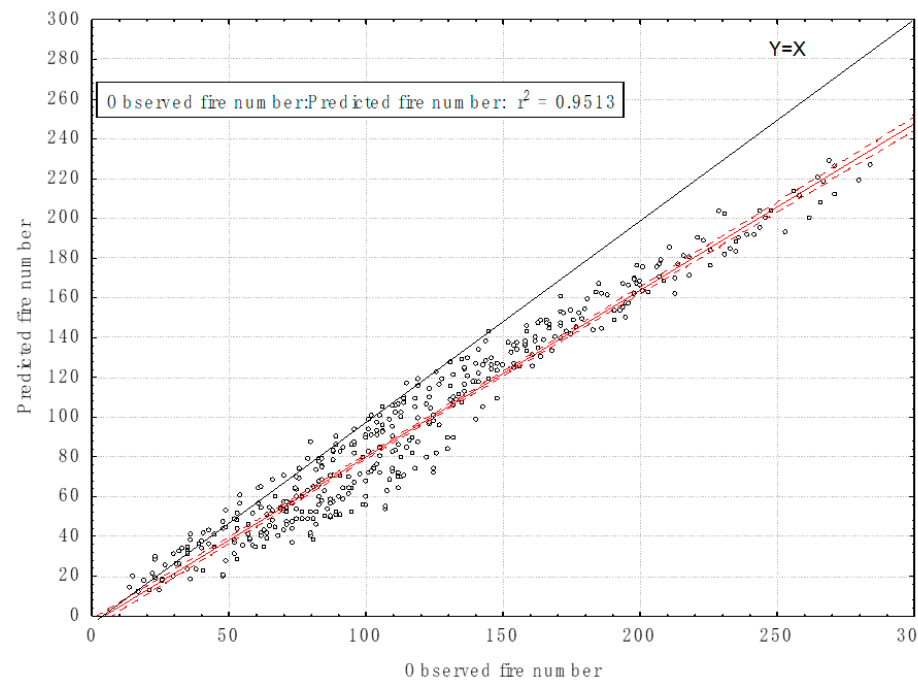
Figure 8. Predicted and observed fire number of periods of different time spans for the northern part of the Daxinganling Region.